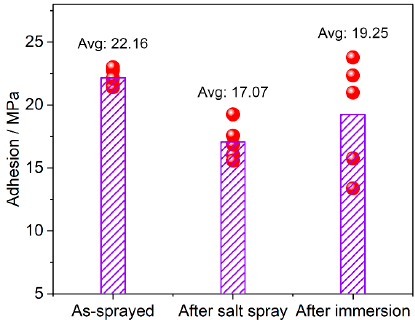
Figure 10. XRD results of the Al coating sample (~0.30 mm) after the immersion test for 3 months.